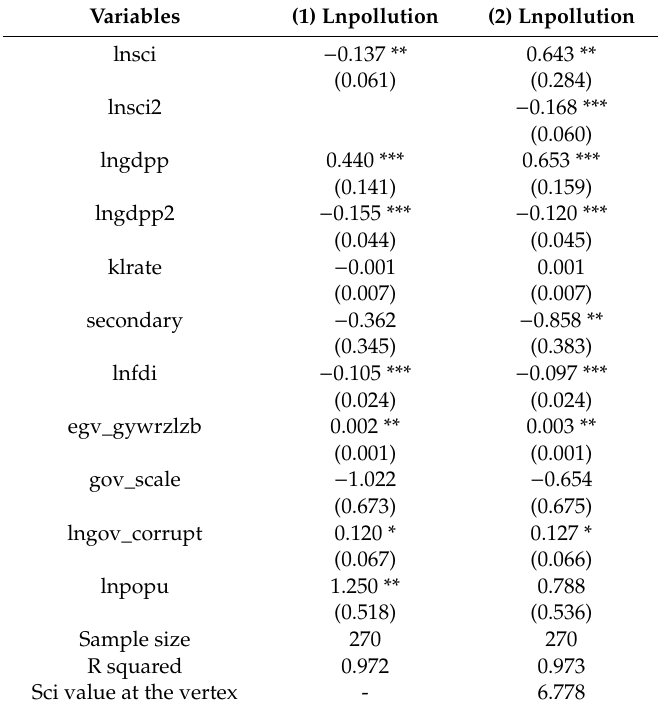
Table 2. Regression results of basic